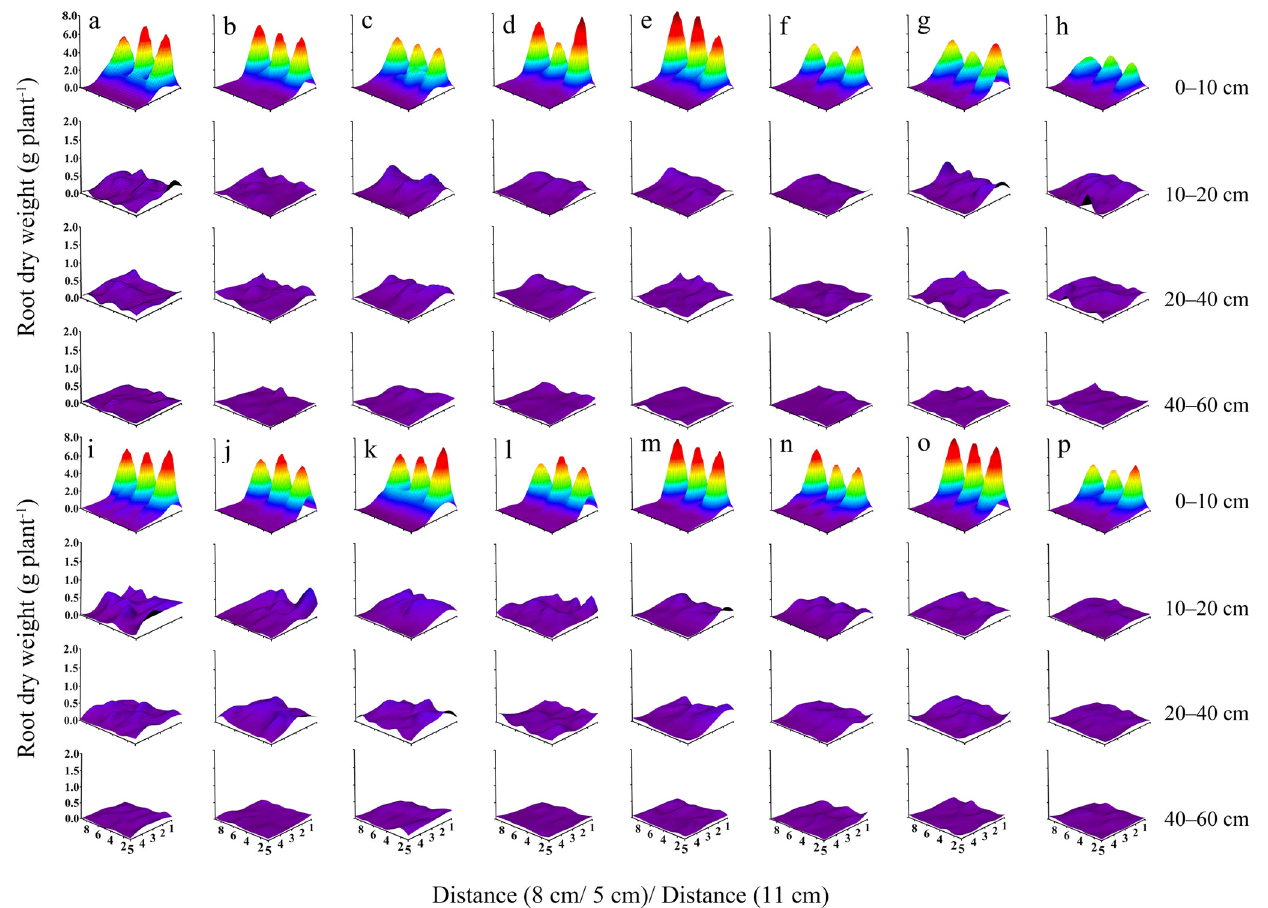
Figure 3. Vertical distribution of root dry weight (RDW) of two maize cultivars (DH618 and SC704) grown at two planting densities (D1 and D2). ( a – d ) RDW at the silking stage in 2019 for ( a ) DH618 grown at D1, ( b ) DH618 grown at D2, ( c ) SC704 grown at D1, and ( d ) SC704 grown at D2. ( e – h ) RDW at maturity in 2019 for ( e ) DH618 grown at D1, ( f ) DH618 grown at D2, ( g ) SC704 grown at D1,